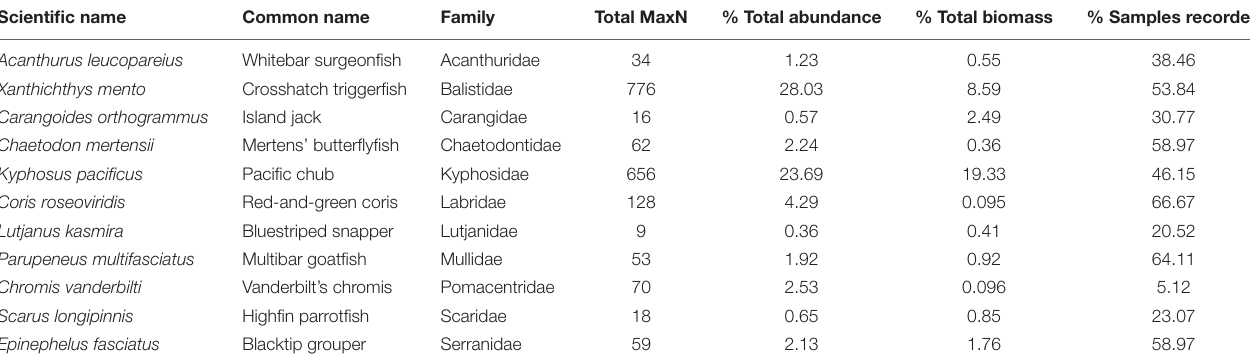
TABLE 1 | Summary of key data indices for the most common species (in terms of relative abundance) in each of the main fish families recorded on